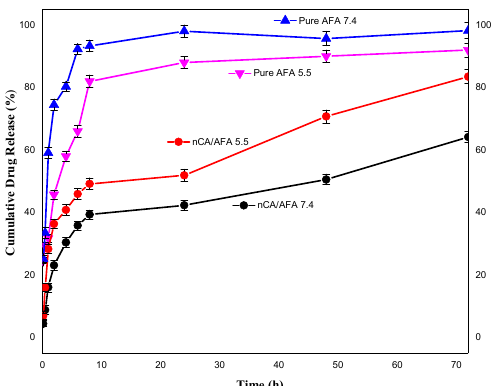
Figure 9. Release profile of pure AFA at pH 7.4 (blue), pure AFA at pH 5.5 (pink), nCA/AFA at pH 5.5 (red), and nCA/AFA at pH 7.4 (black).